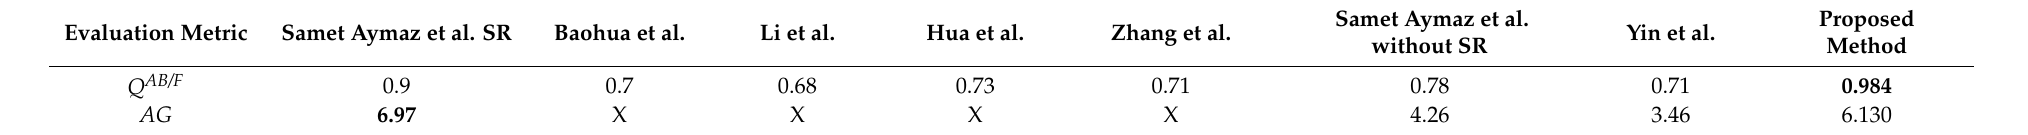
Table 5. The outcomes for the clock image and comparisons with existing techniques in the literature ([24]). Evaluation